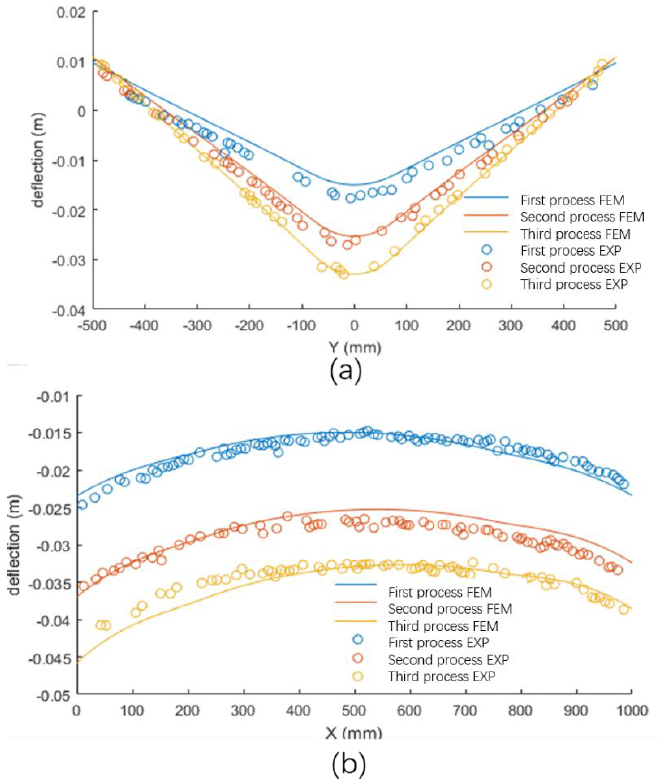
S S ; ( b ) view section  S S B B L L